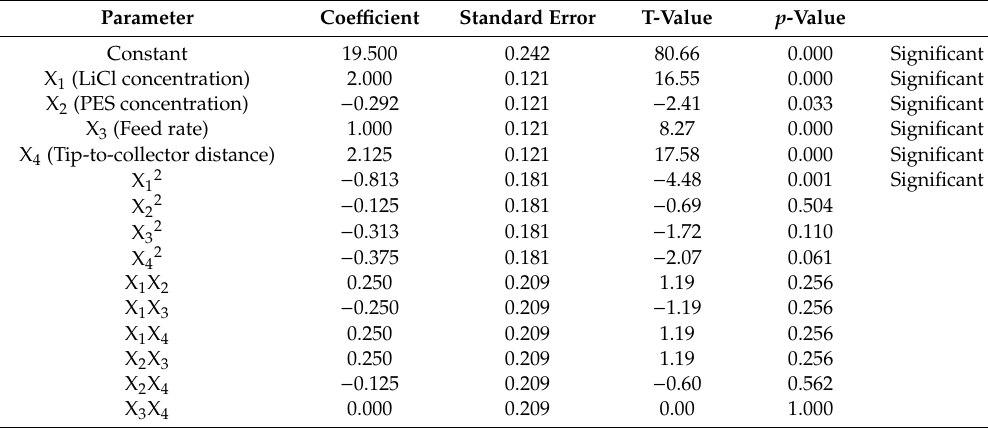
Figure 1. Parity plot of the measured applied voltage and predicted applied voltage ( a ), the measured fiber diameter and predicted fiber diameter ( b ). Table 4. The regression analysis in the fitted quadratic polynomial model for applied voltage based on the t-statistic. R 2 = 0.9828, R adj2 =